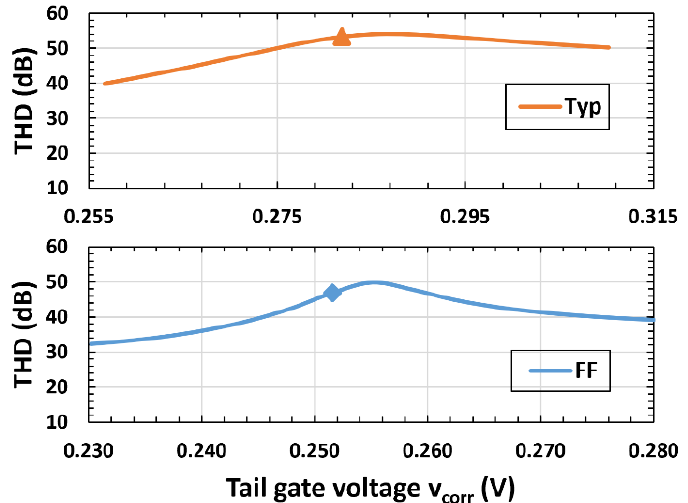
Figure 9. THD of the track-and-hold circuit from transient simulation for typical and fast process corner. The markers denote the 𝑣 𝑐𝑜𝑟𝑟 voltage obtained by the MATLAB model.